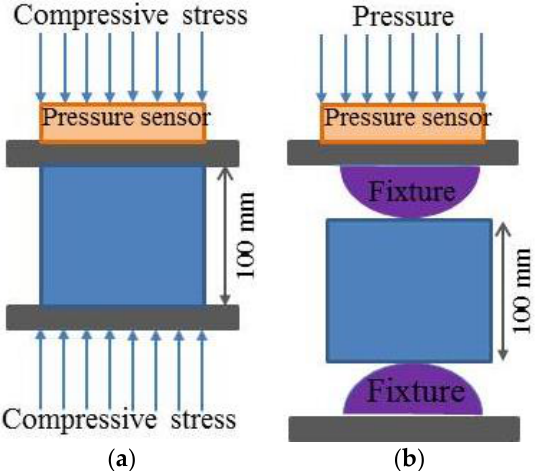
Figure 5. Static compression and splitting tensile tests of specimens. ( a ) Static compression test and ( b ) splitting tensile test.